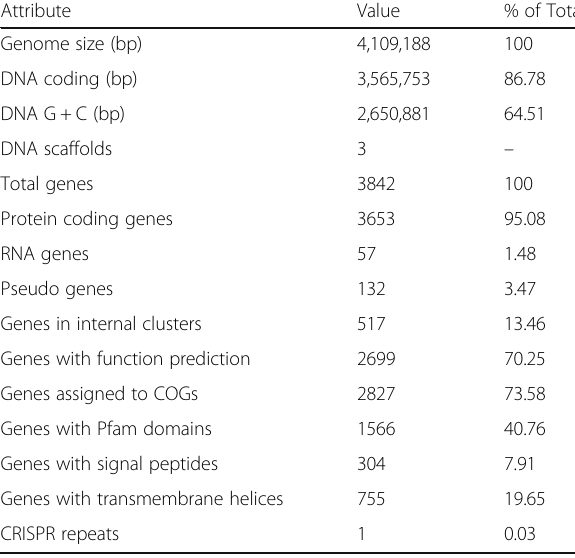
Table 4 Genome statistics of Croceicoccus marinus E4A9 T Attribute